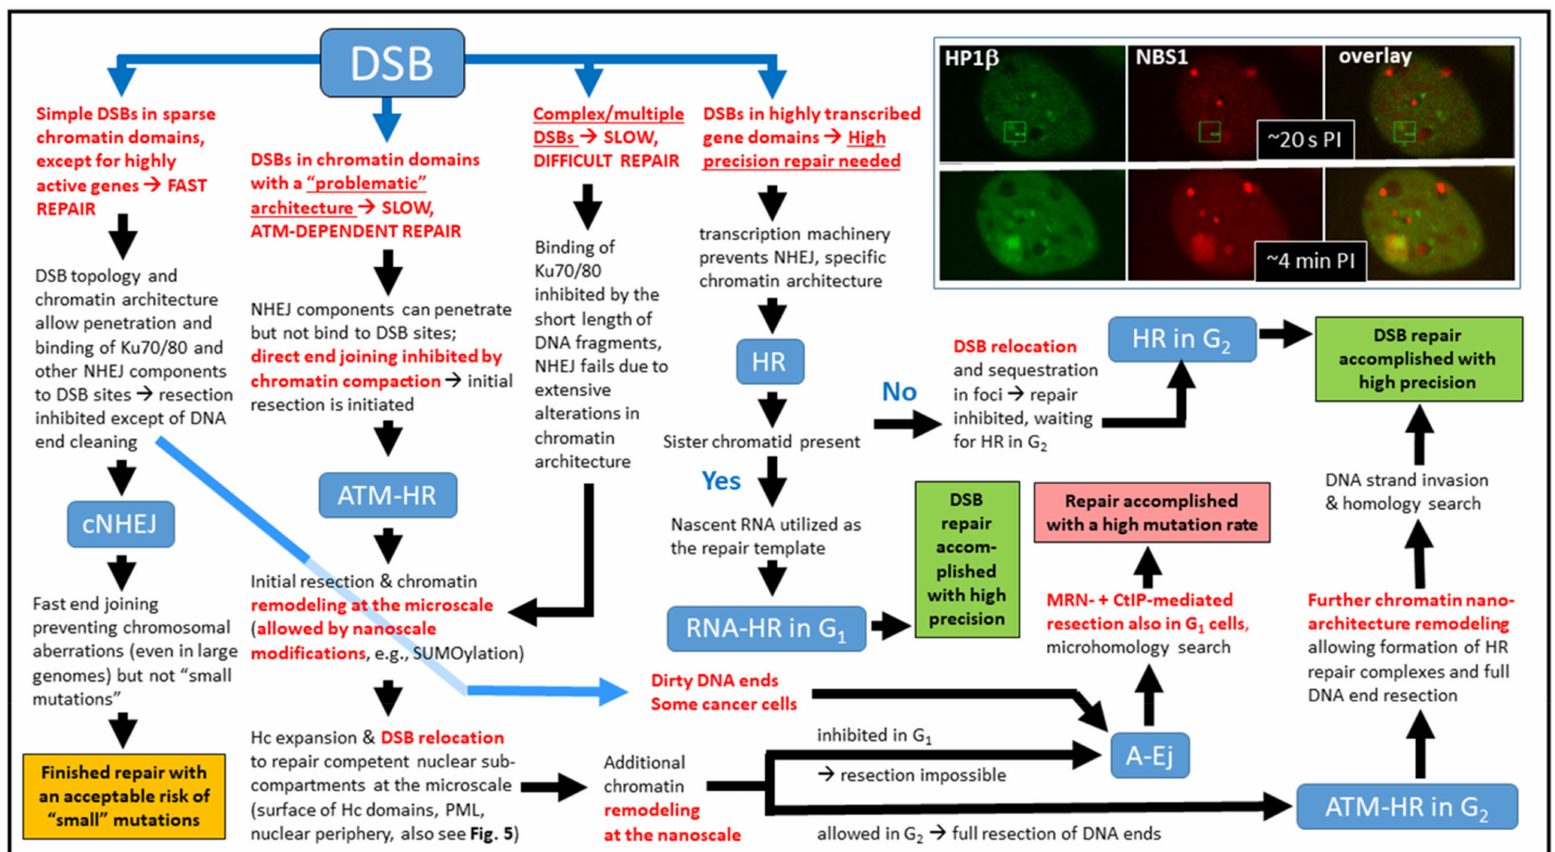
Figure 4. Schematic summary of the main steps of a possible decision-making scenario for particular repair pathway activation at individual DSB sites. The influence of the DSB properties and architecture of the affected chromatin domain is highlighted. Insert: DSB damage is accompanied by architectural reorganization (decondensation) of a heterochromatin domain at the microscale, which is necessary for repair continuation in this chromatin domain type (see also Figure 5). Shown is also infiltration of the affected domain by NBS1 protein, confirming DSB induction by a UV laser (see Falk et al. 2014 [77]). HP1 β was labeled in living MCF7 cells by GFP- and NBS1 by RFP